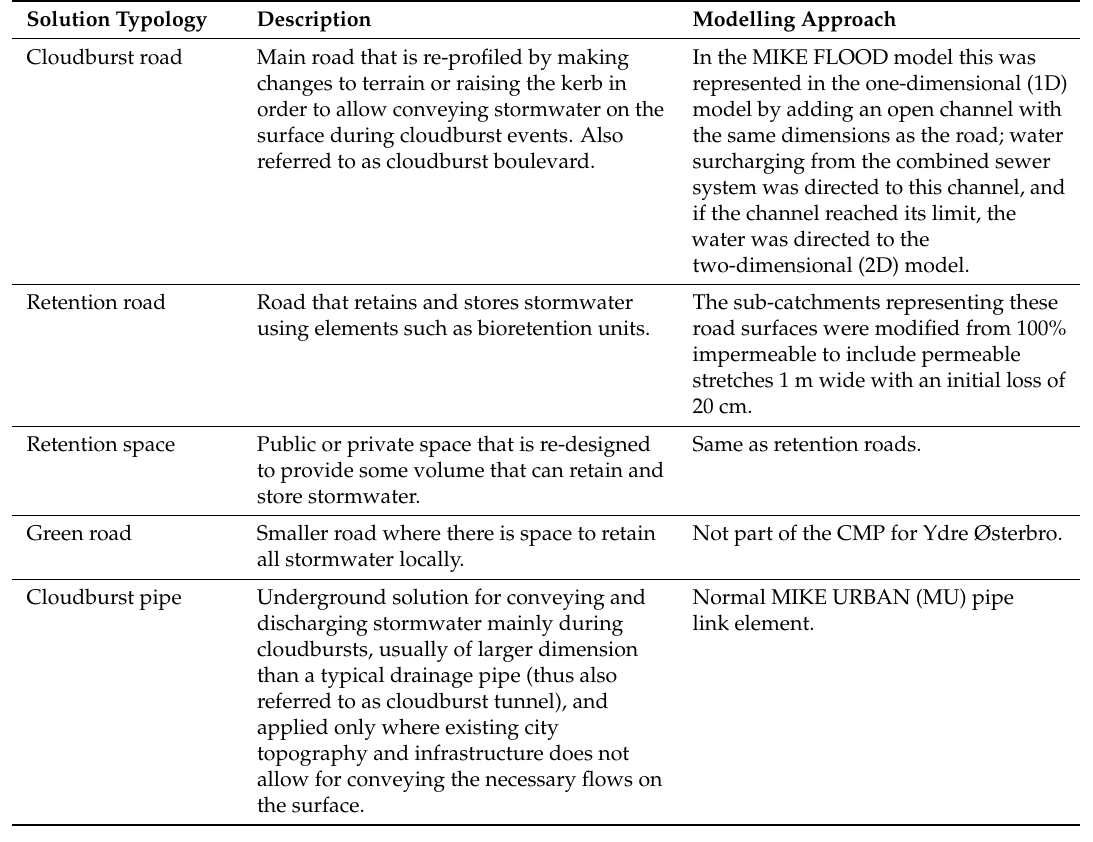
Table 1. Typology of measures used in the cloudburst management plan (CMP) [11] and how they were modelled in this